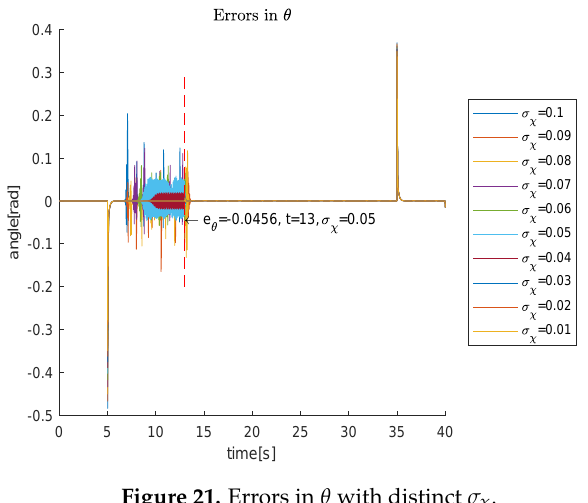
Figure 21. Errors in θ with distinct σ χ .